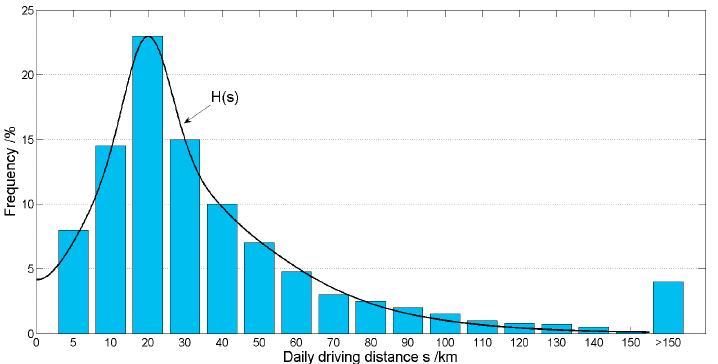
Figure 6. Distribution of daily driving distance.